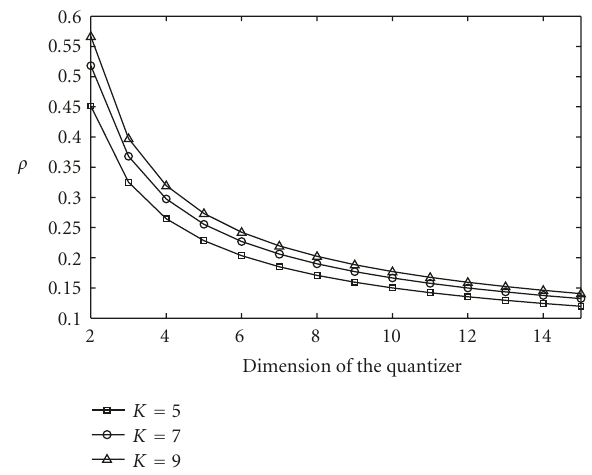
Figure 6: ρ as a function of the dimension for various values of K